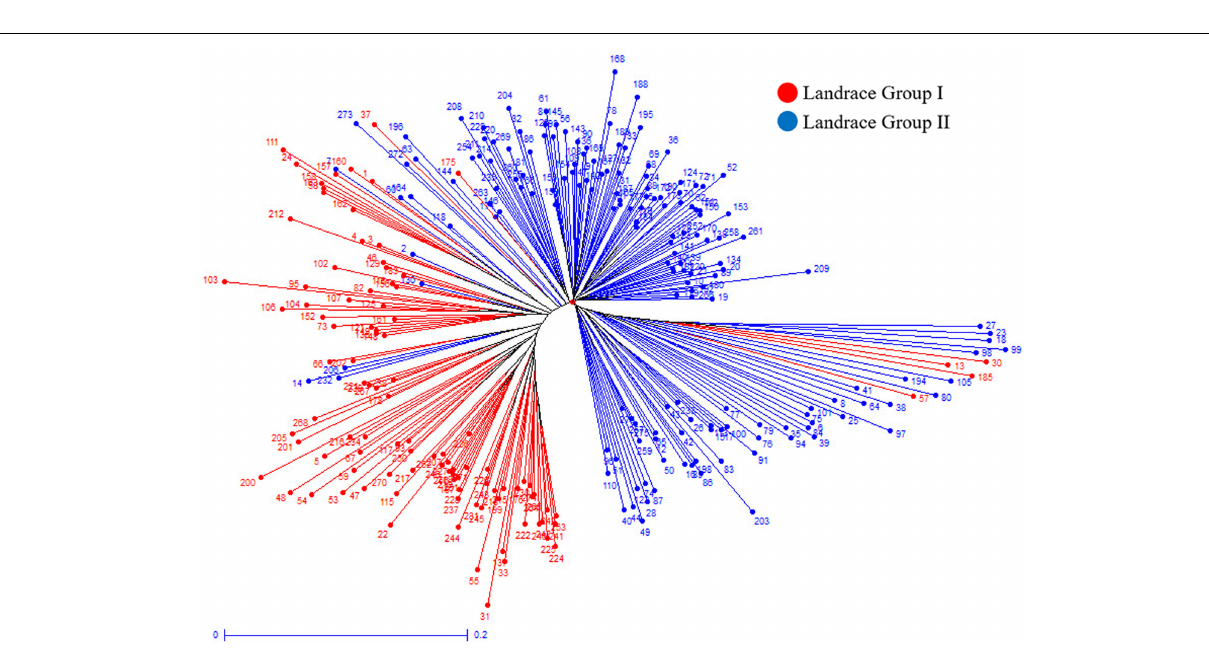
Frontiers in Plant Science |